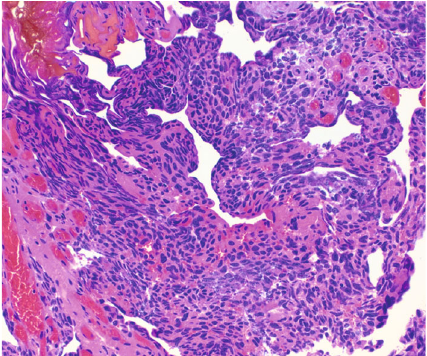
Figure 3: Marked thermal artifact; cell block (H&E, high power